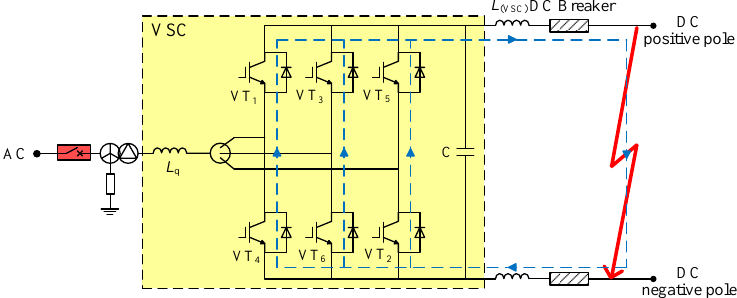
Figure 5. The second stage discharge circuit of VSC fault.